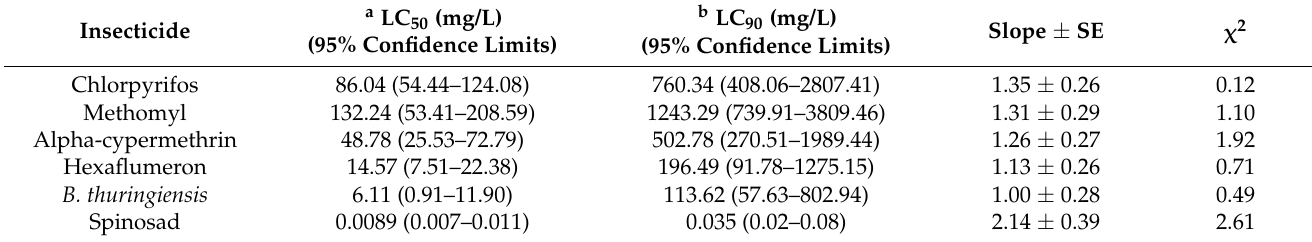
Table 2. Susceptibility of the 4th instar larvae of a laboratory strain of S. littoralis to the tested insecticides. Castor leaves were dipped in six concentrations of each tested insecticide. Five replicates, ten larvae each, were used for each concentration. (i.e., 50 larvae/concentration). The larvae were allowed to feed for 24 h on leaves treated with conventional insecticides, and for 72 h post-treatment with bioinsecticides. LC 50 and LC 90 values of the tested insecticides were calculated using the (LdPLine©) package software according to the Log-Probit analysis